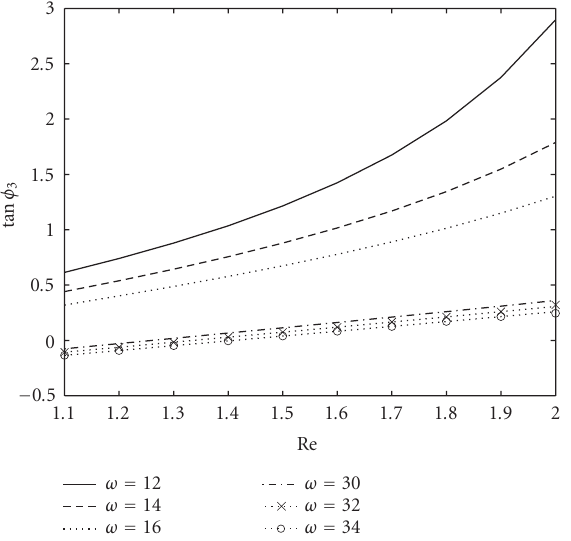
Figure 5.4. Tangent of phase shift of Nusselt number tan φ 3 for S = 1 . 0, Pr = 0 . 72, Ec = 10.